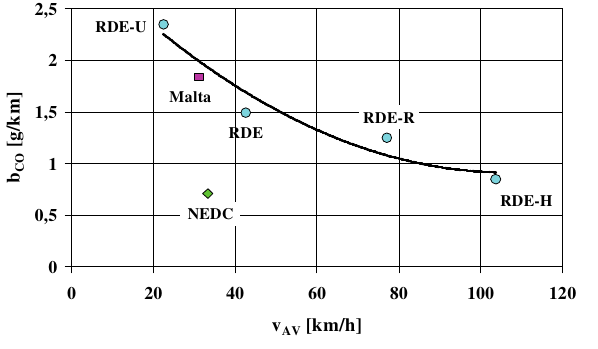
Fig. 19. The relation between the mean road emission of carbon dioxide – b CO2 and the mean vehicle speed – v AV in each test cycle